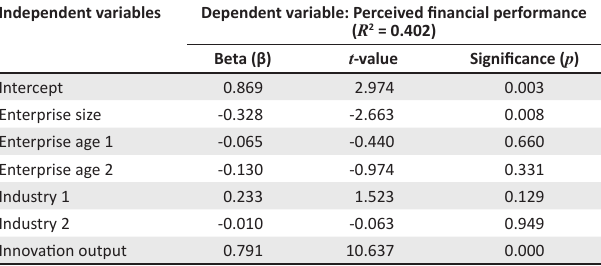
TABLE 4 : Regression results: Innovation output and perceived financial performance.